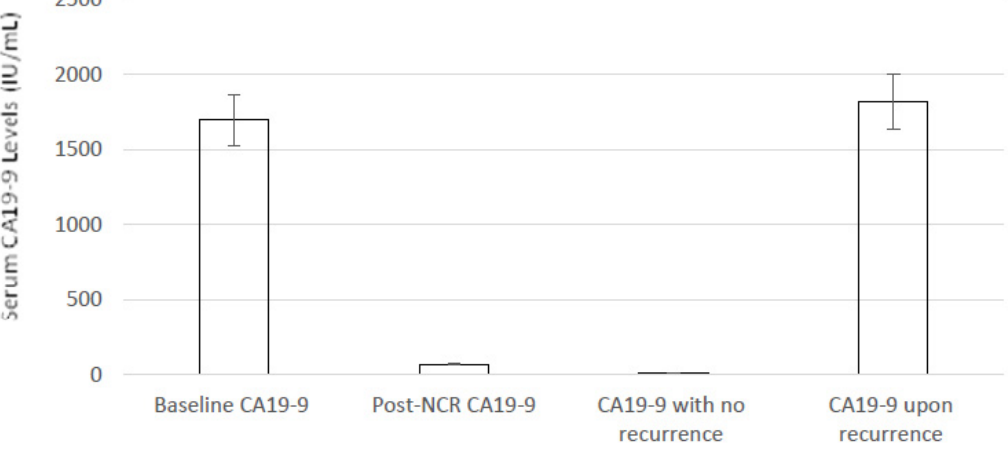
Figure 2. Serum CA19–9 levels in patients pre ‐ and post ‐ NCR for BR ‐ PDAC.